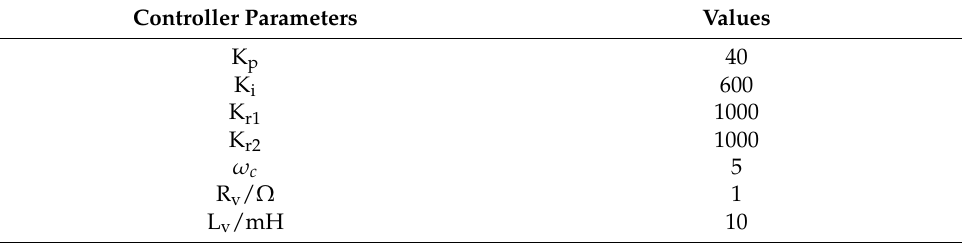
Table 2. Controller